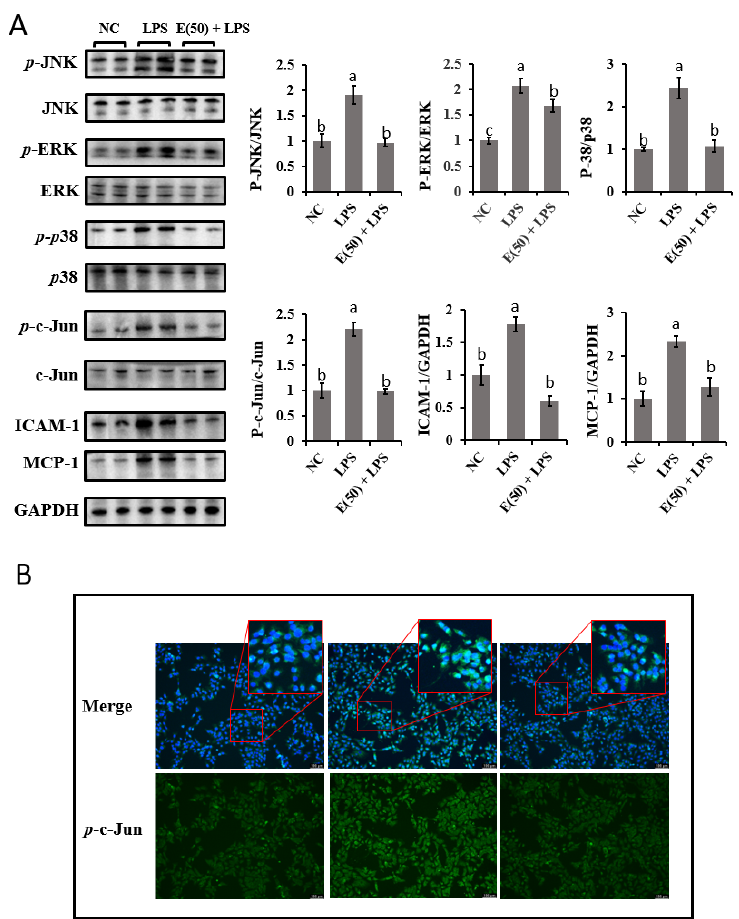
Figure 5. The effect of EGCG pretreatment on LPS-induced activities of MAPK-signaling-involved components. The concentration and timing of EGCG treatment to cells were selected as 24 h at a concentration of 50 μ M. ( A ) Immunoblots and calculated gray intensity for the evaluation of phosphorylated level of MAPK signaling proteins. For ICAM-1 and MCP-1, protein expression was normalized by comparing with GAPDH. ( B ) Immunofluorescence was determined for the import of phosphorylated c-Jun into the nucleus. Cells were observed at 200 × magnification. Results are expressed as means ± S.E.M. Letters in superscript indicate that the difference between groups was significant ( p < 0.05). Experiments were performed as three independent